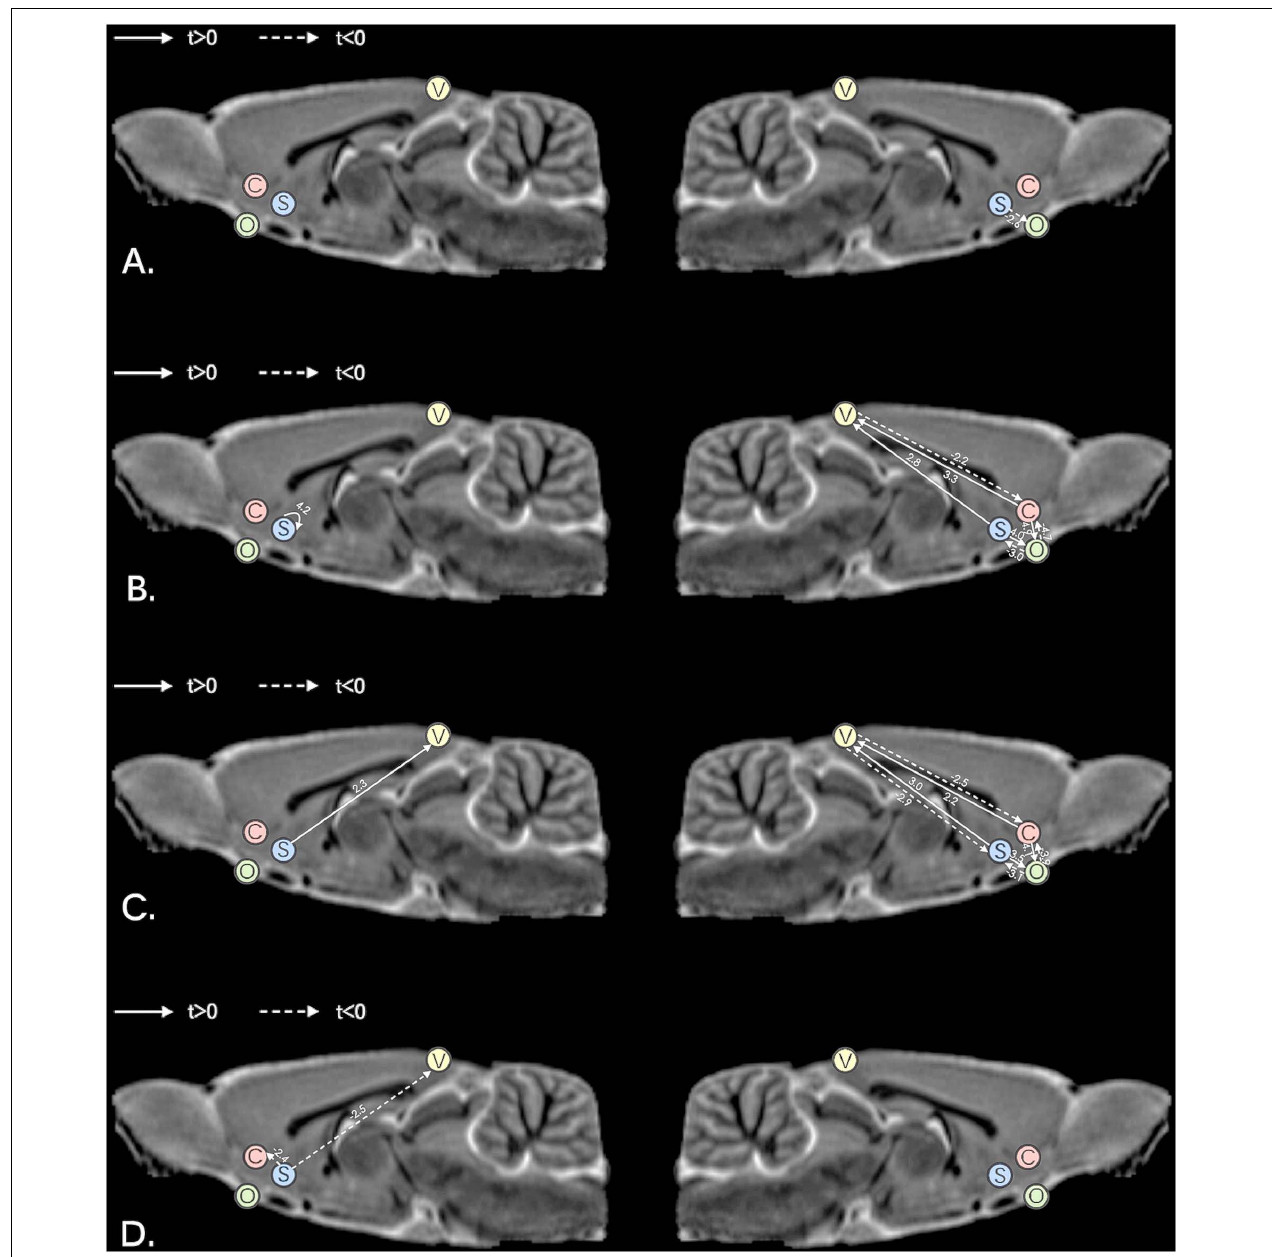
FIGURE 4 | Comparisons of effective connectivity in the left hemisphere and right hemisphere; (A) comparisons between MAM-sham and vehicle-sham groups; (B) comparisons between MAM-rTMS and MAM-sham groups; (C) comparisons between MAM-rTMS and vehicle-rTMS groups; (D) comparisons between vehicle-rTMS and vehicle-sham groups; MAM, methylazoxymethanol acetate; rTMS, repetitive transcranial magnetic stimulation; V, Visual Cortex; C, Nucleus Accumbens Core; S, Nucleus Accumbens Shell; O, Orbitofrontal